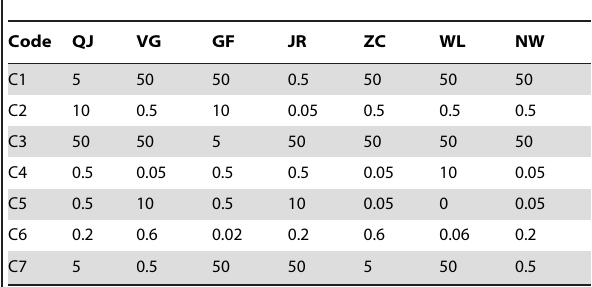
Table 2. Example of randomly generated scenarios (Group 1).